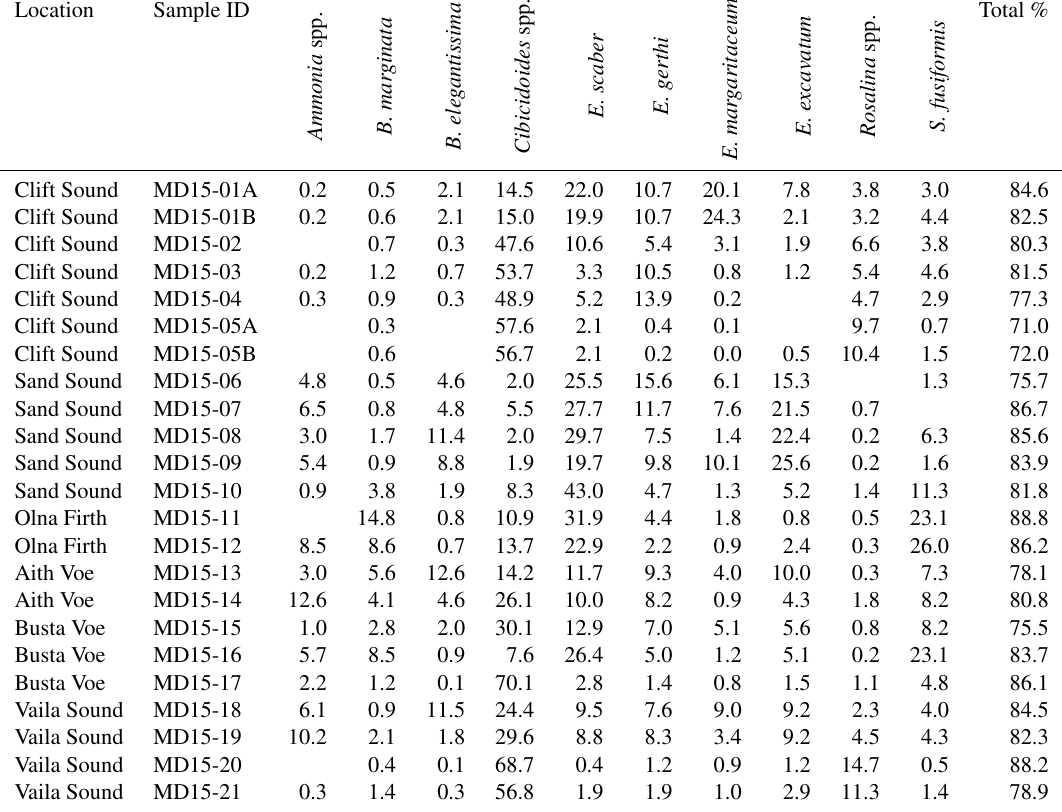
Table 2. Relative abundance of the 10 dominant